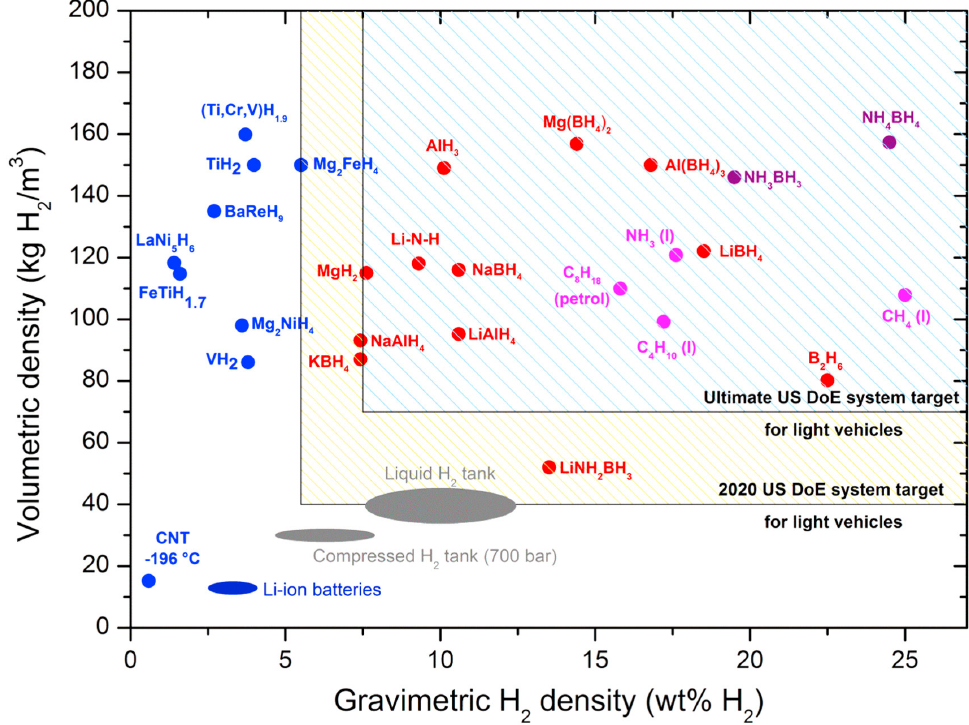
Figure 1. Overview of different hydrogen storage systems and their volumetric and gravimetric hydrogen density. The U.S. Department of Energy targets for the hydrogen storage system are also shown for comparison. Copyright 2017, Elsevier. Reproduced with permission from [7].